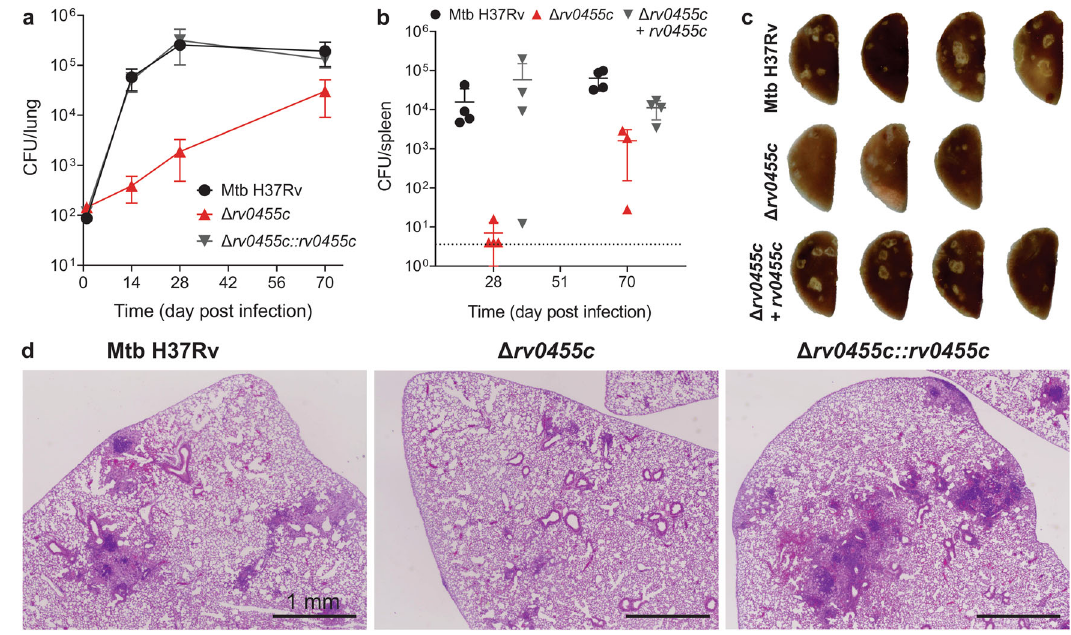
Fig. 6 Rv0455c is a virulence factor of M. tuberculosis in mice. C57BL/6 mice infected with the WT M. tuberculosis parent strain (ML2710), the Δ rv0455c mutant (ML2711), and the complemented strain (ML2701). Colony-forming unit (CFU) counts in the lungs ( a ) and spleens ( b ) of mice infected with the indicated strains. Data represent the mean ± s.d. of four mice per time point. Note that one mouse infected with Δ rv0455c mutant was euthanized on day 51 due to an unrelated illness. Source data are provided in the Source Data fi le. c Gross pathology scans of left lung lobes of mice harvested on day 70 after infection. d Histopathology of lungs of mice harvested on day 70 after infection. The scale bar is 1 mm. Data were obtained from two independent experiments and representative images are